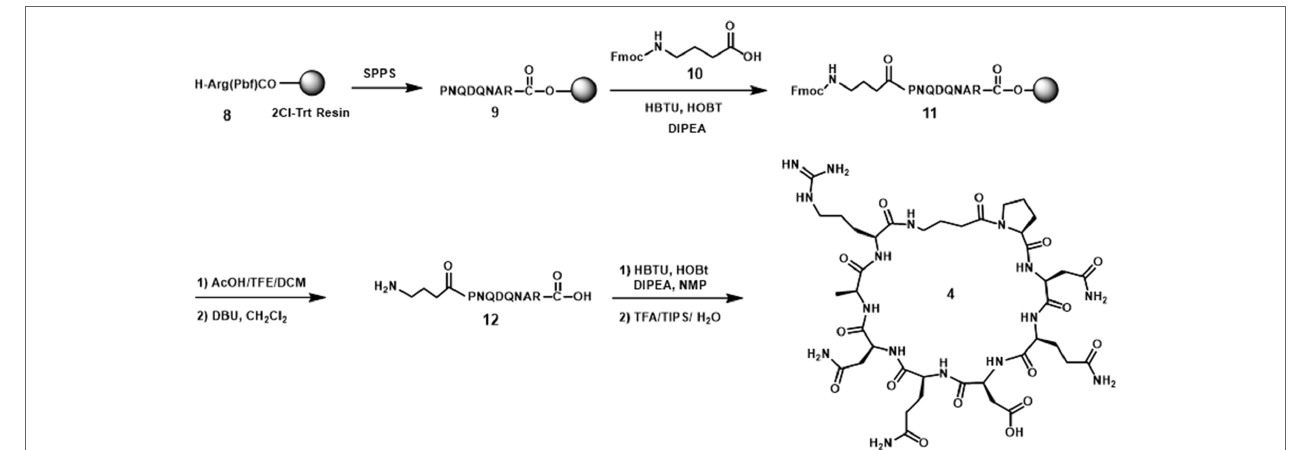
SCHEME 1 | Synthesis of cyclic peptide 4